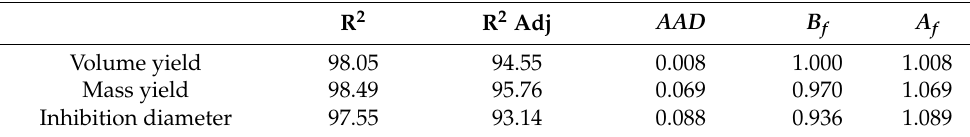
Table 3. Validation